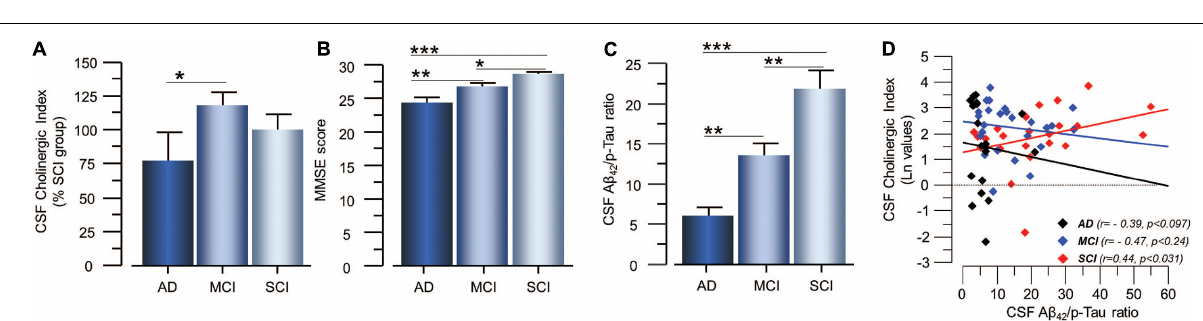
The plasma ChAT protein correlated positively with t-tau ( r = 0.40, n = 48, p < 0.005, Figure 5C ) and p-tau ( r = 0.31, n = 48, p < 0.03, Figure 5D ), but not with the CSF A β 42